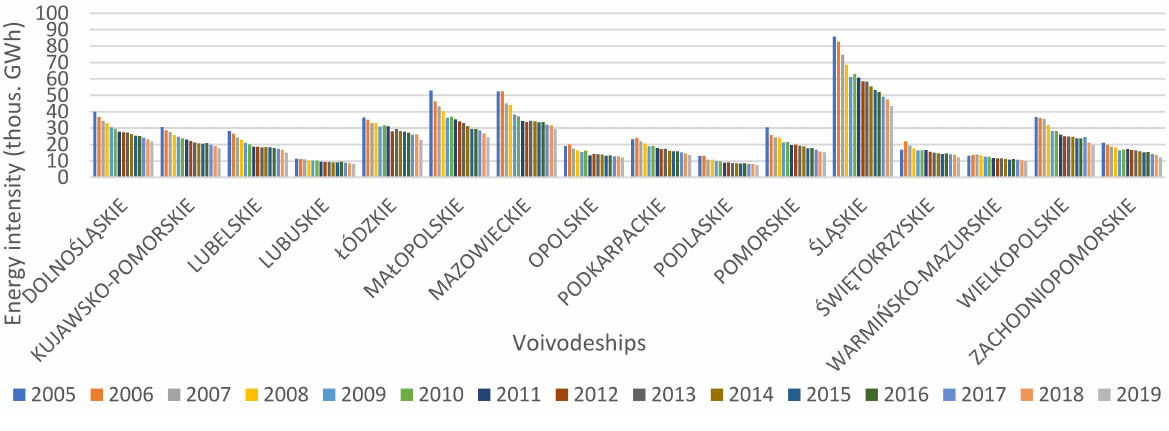
Figure A8. Energy intensity as total energy consumption (thous. GWh) in relation to GDP per capita (thous. PLN) in individual voivodeships of Poland in 2005–2019. Source: own elaboration based on LDB.